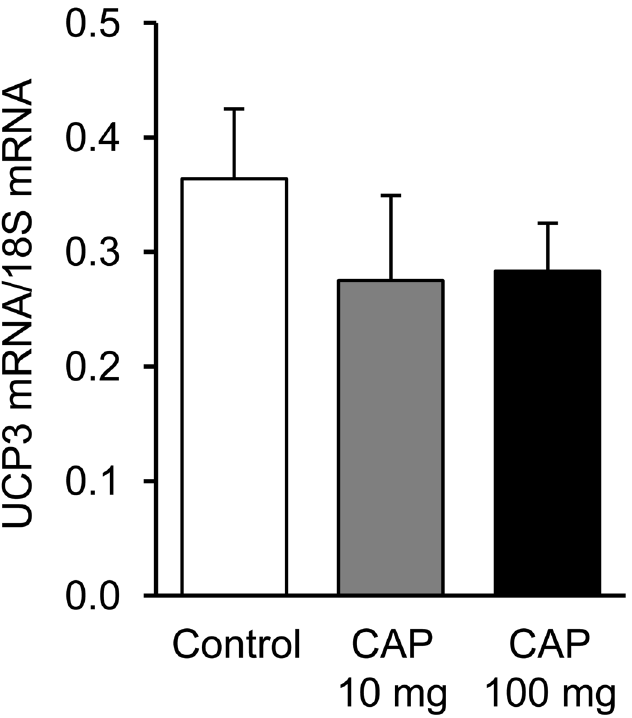
Fig 6. UCP3 gene expression. Basal UCP3 mRNA levels in gastrocnemius muscle normalized to 18S mRNA used as an internal standard in animals daily administered during two weeks with vehicle (control) or capsiate (CAP) at two different concentrations (10- or 100-mg/kg body weight). Data are means ±